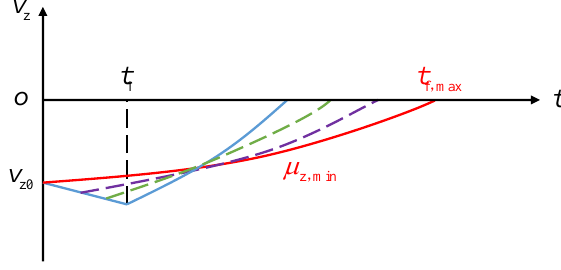
Figure 4. Motion schematic diagram in the Z